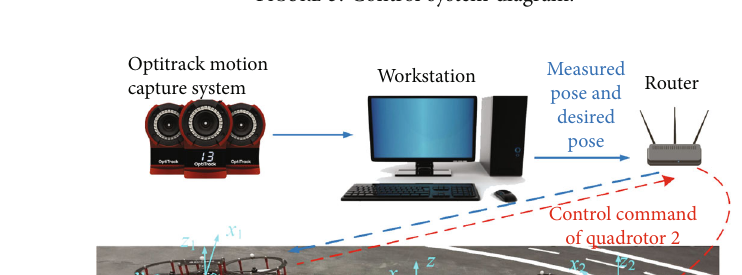
Figure 3: Control system diagram.